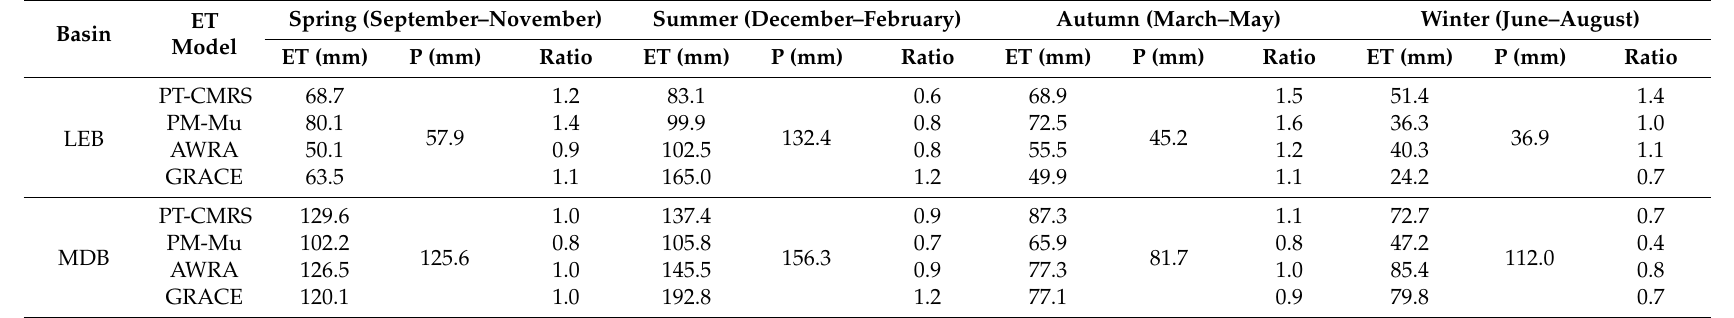
Table 2. Mean seasonal ET from the four ET models and their ratio to rainfall (denoted as P) for the period 2003–2010.